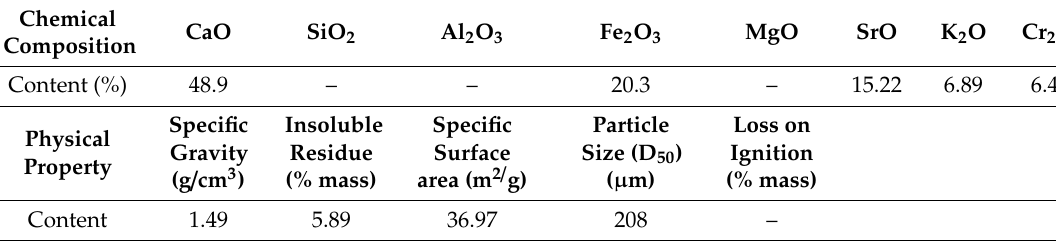
Table 6. Physical and chemical properties of acacia